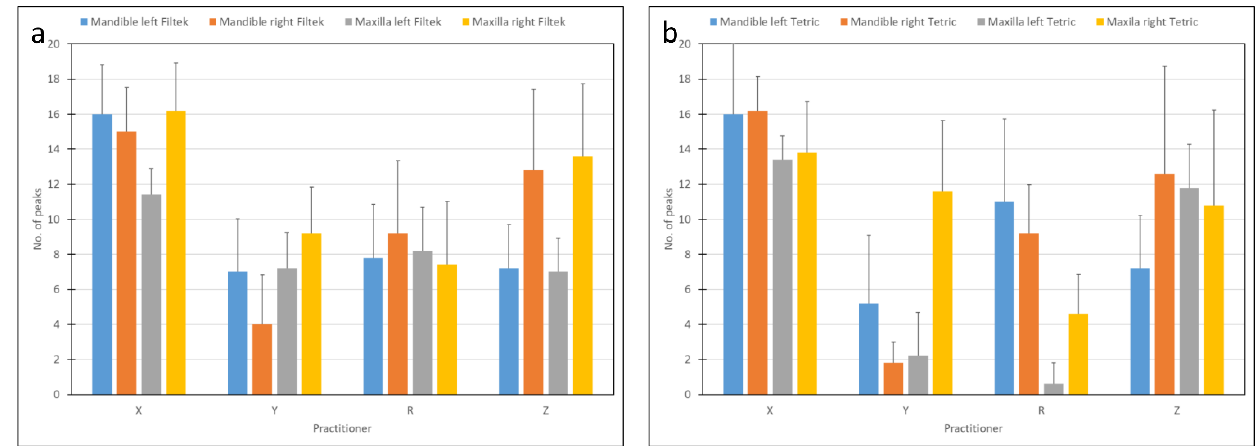
Figure 7. Number of peaks as related to practitioner and materials: ( a ) Filtek, ( b ) Tetric.